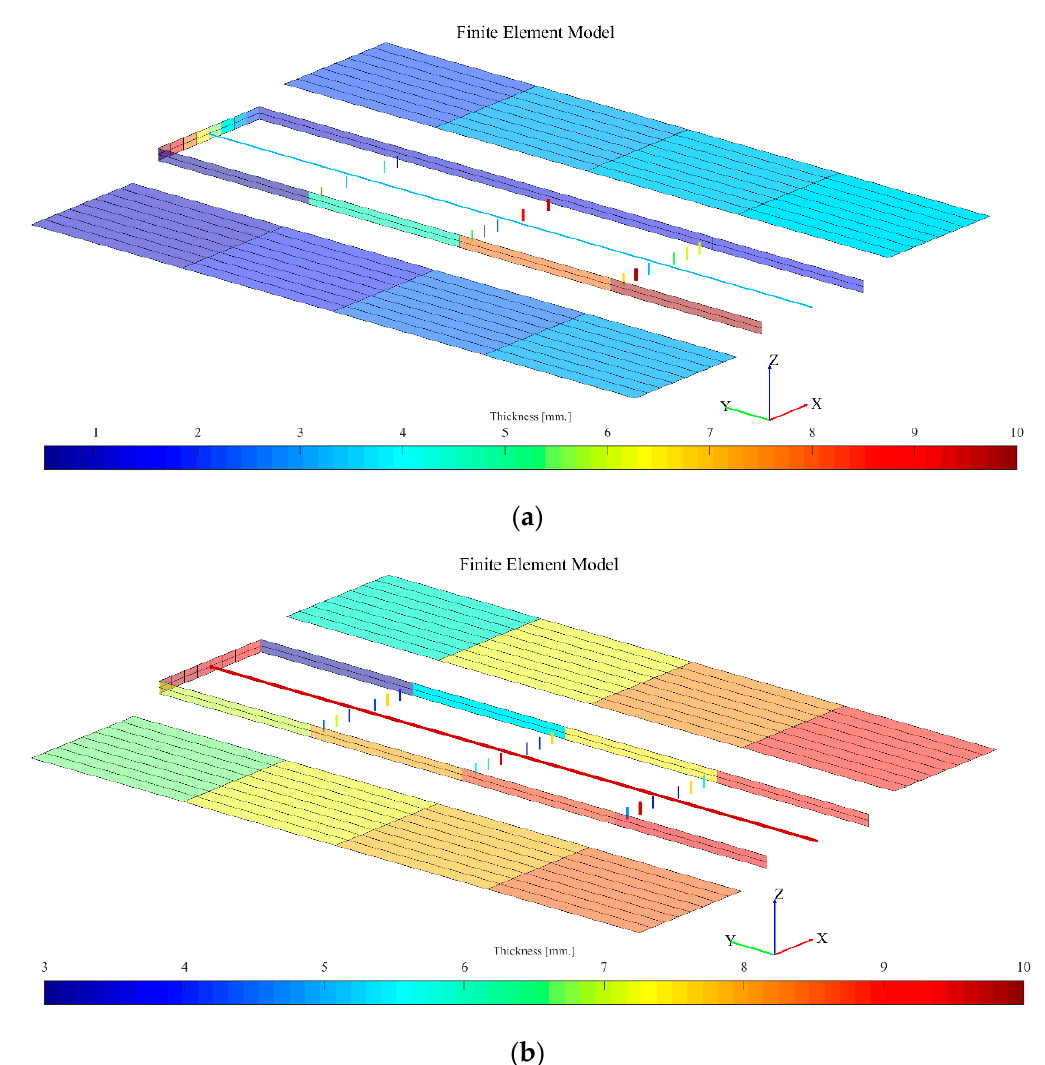
Figure 11. Thickness and skeletal rods diameter plot of the selected optimum solutions ( a ) 1 and ( b ) 10 Case I with color bar.